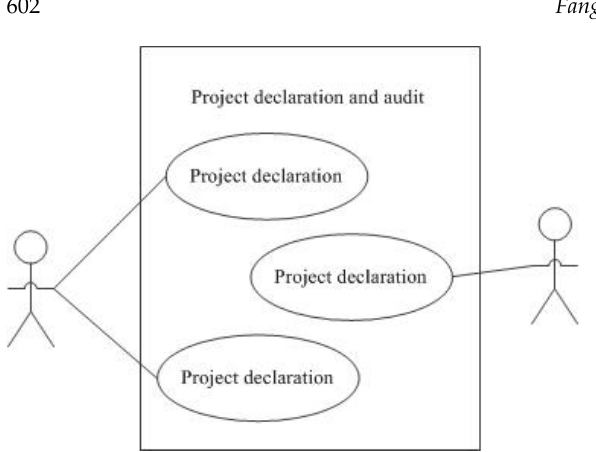
Fig. 3. Function use case diagram of project declaration and